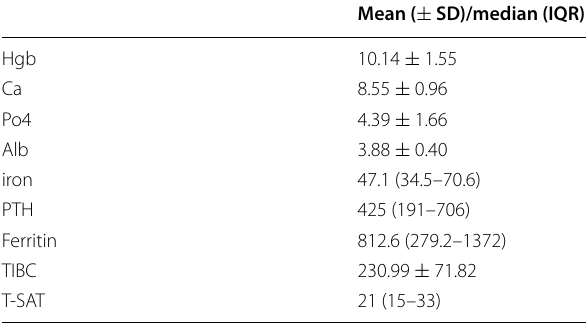
Table 2 Basic pre-fasting lab investigations for study population